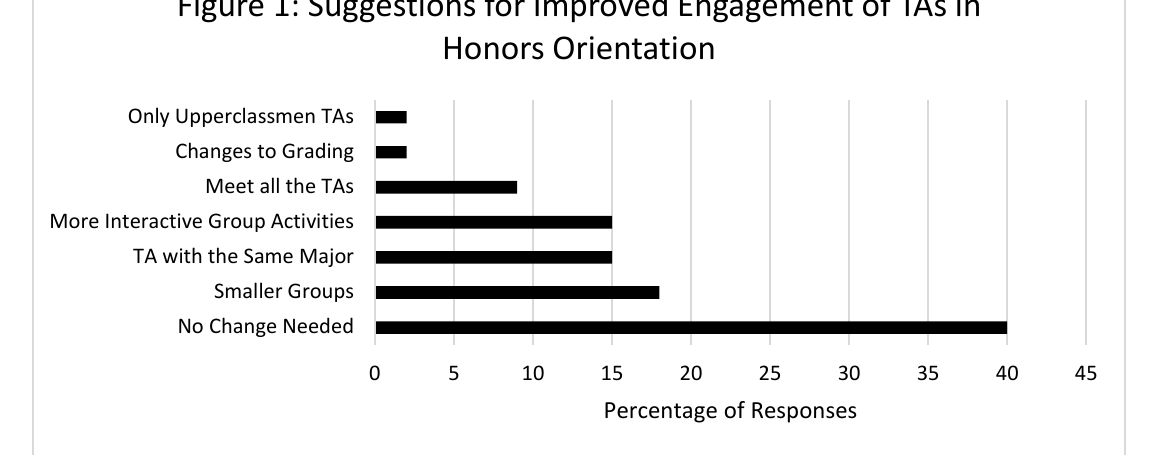
Figure 1: Suggestions for Improved Engagement of TAs in Honors